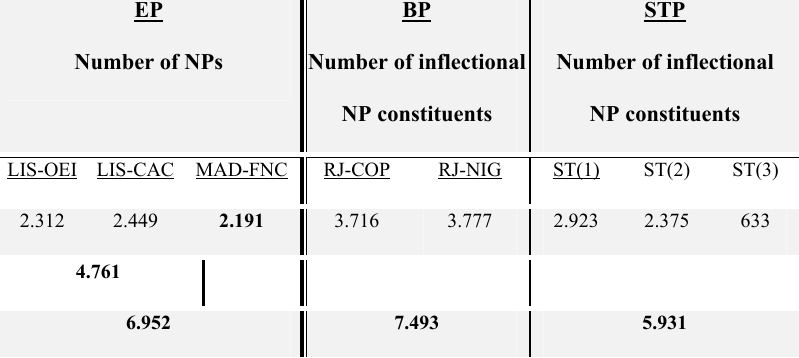
Table I. Number of observed data by variety/sample EP BP STP Number of NPs Number of inflectional Number of inflectional NP constituents NP constituents LIS-OEI LIS-CAC MAD-FNC